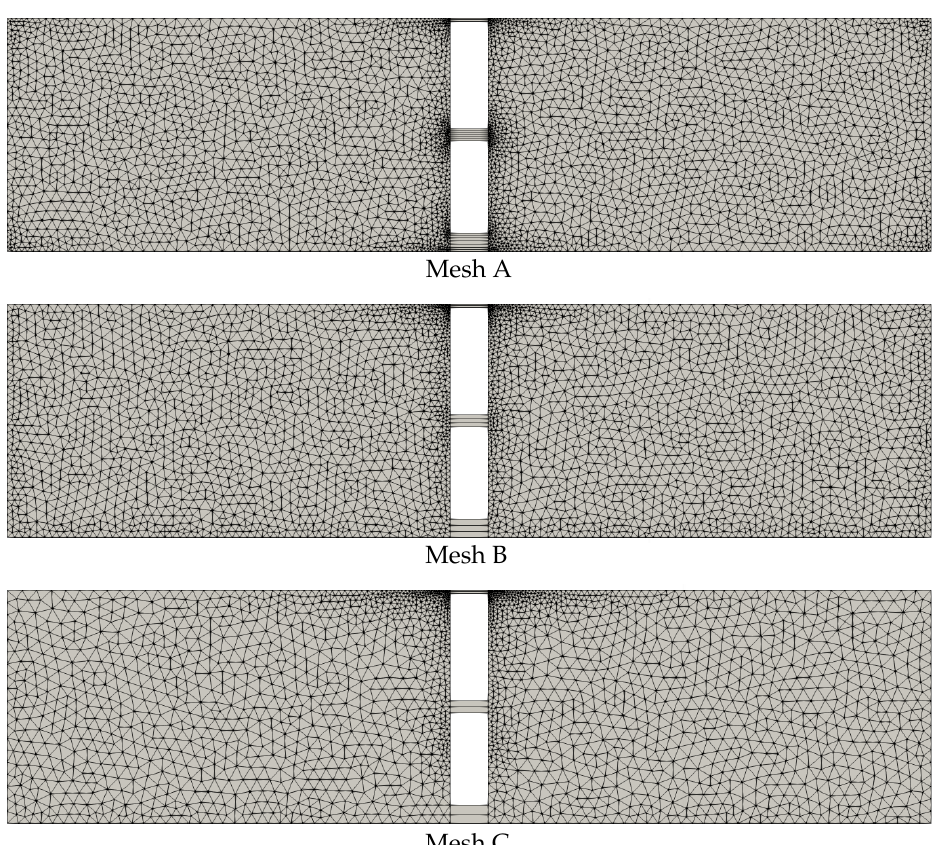
Figure 11. Computational meshes for one-dimensional orifice element model simulations of violent slosh test case.